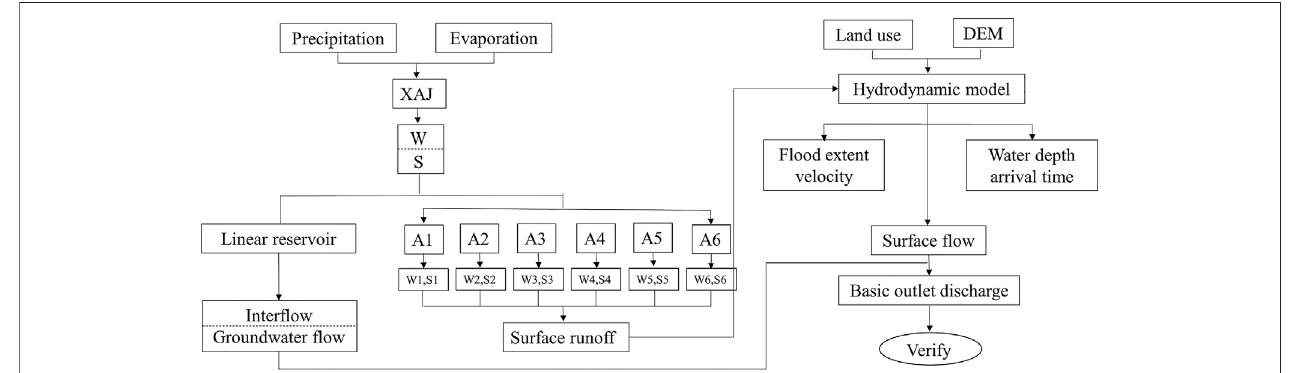
FIGURE3| FlowchartofthecoupledXAJ.Note:W,tensionwaterstoragecapacitycurve;S,freewaterstoragecapacitycurve;W1,tensionwaterstoragecapacity curve of farmland; W1, tension water storage capacity curve of farmland; W2, tension water storage capacity curve of forest land; W3, tension water storage capacity curveofgrassland;W4,tensionwaterstoragecapacitycurveofwaterbody;W5,tensionwaterstoragecapacitycurveofurbanarea;W6,tensionwaterstoragecapacity curveof unused land; S1, free water storage capacitycurveof farmland; S2, free water storage capacity curve of forest land; S3, freewater storage capacity curve of grassland; S4, free water storage capacity curve of water body; S5, free water storage capacity curve of urban area; S6, free water storage capacity curve of unused land; A1, the area of farmland; A2, the area of forest land; A3, the area of grassland; A4, the area of water body; A5, the area of urban area; A6, the area of unused land.